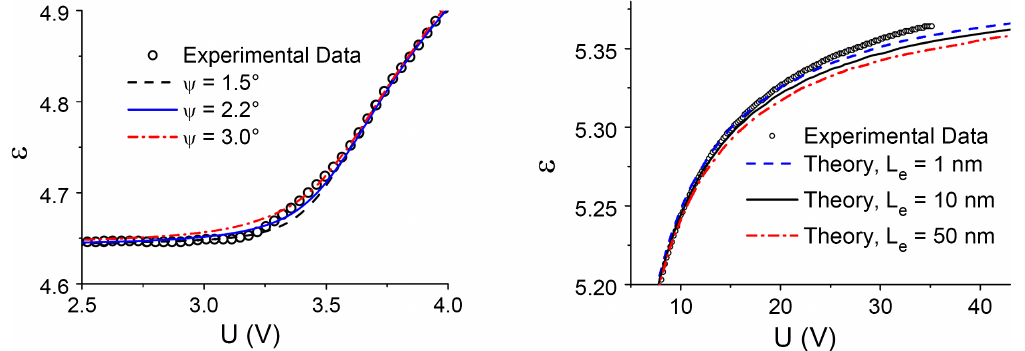
FIG. 24. Estimations of the pretilt angle ψ m (left) and the anchoring extrapolation length L m M phase ( T ¼ 95 X